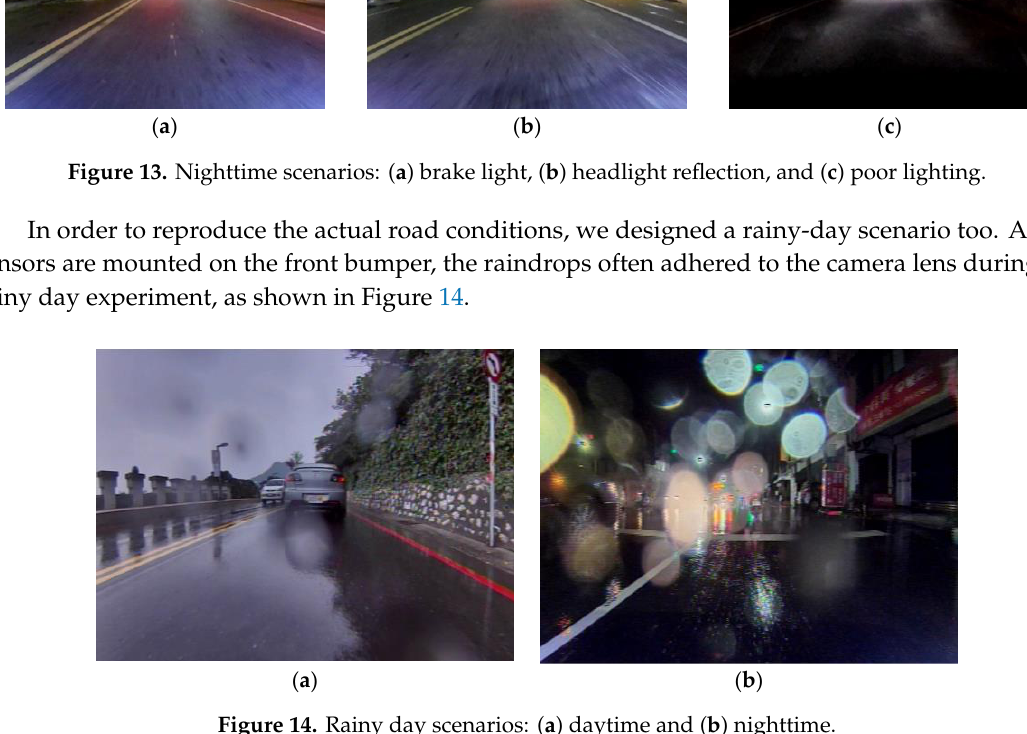
Figure 14. Rainy day scenarios: ( a ) daytime and ( b ) nighttime.